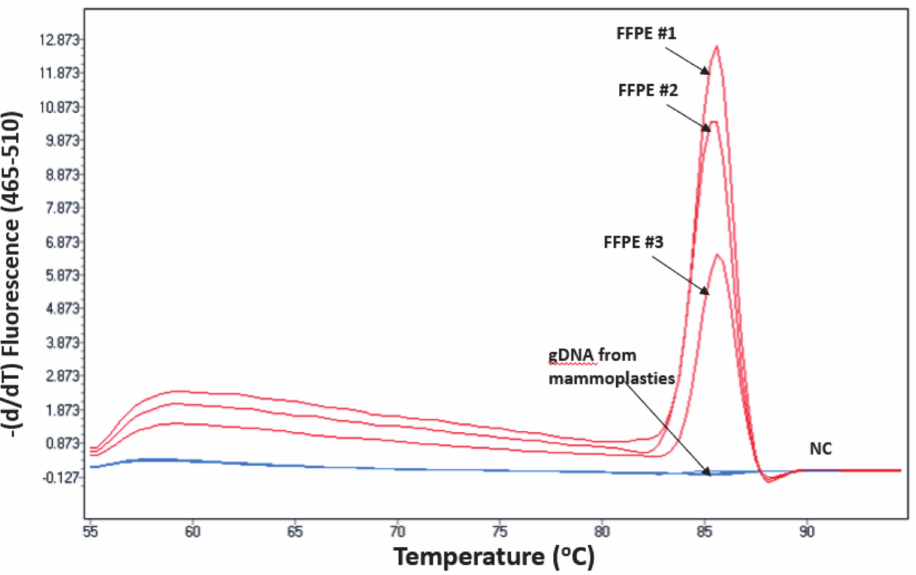
Figure 6. ESR1 NAPA assay: detection of the Y537C mutation in primary ER-positive breast tumour tissues (FFPEs) and mammoplasties. NC: PCR negative control.